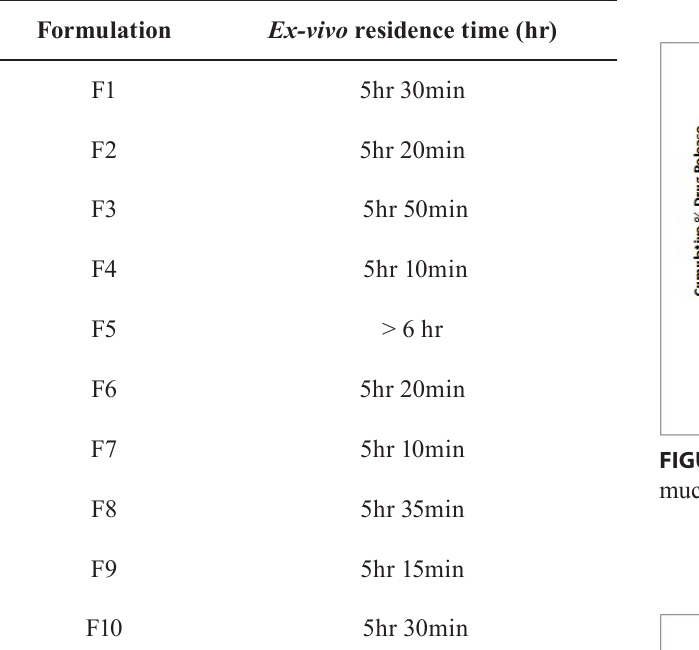
TABLE V - E x-vivo residence time of buccal tablets